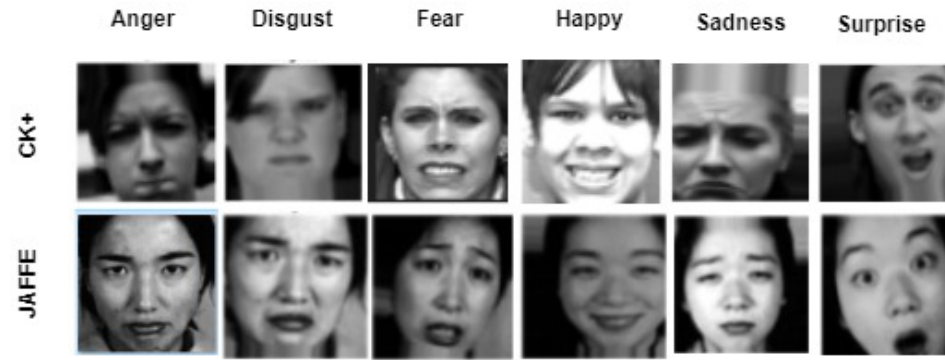
Figure 5. Samples of Augmented Images Generated.